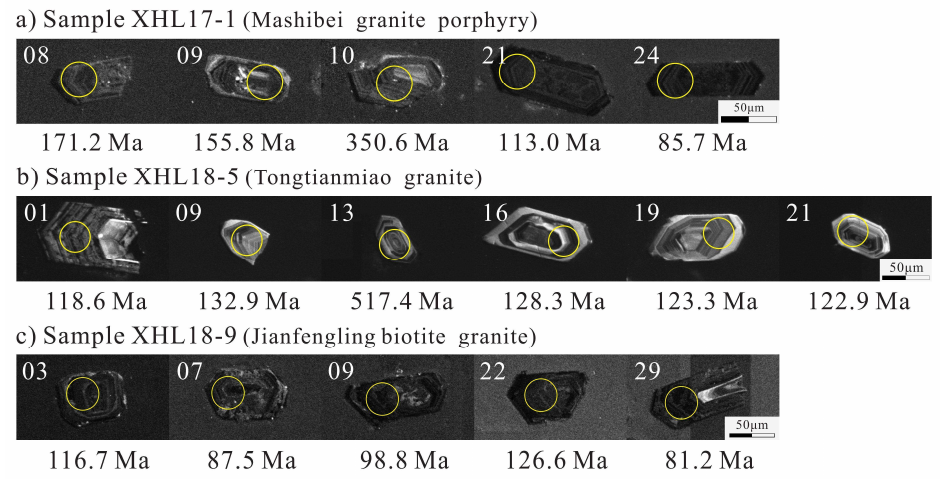
Figure 10. Zircon CL images of ( a ) sample XHL17-1; ( b ) sample XHL18-5; ( c ) sample XHL18-9. Zircons in sample XHL17-1 (Maishibei granitic porphyry) are mostly in the range of 75 μm to 100 μm, and the grains are euhedral prismatic with length/width ratios of 1.5:1 to 3.5:1 (Figure 10a). Most of them are dark in color with weak, variable oscillatory zoning, while some have inherited core or marginal accretion.